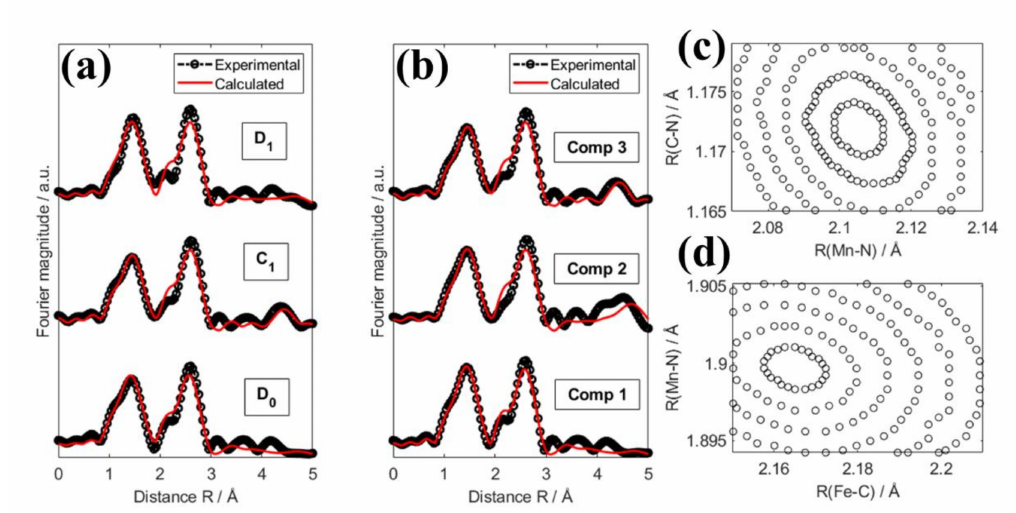
Figure 6. EXAFS fitting analysis on ( a ) the most relevant states of charge, i.e., D 0 , C 1 , and D 1 , as well as ( b ) all three components retrieved by the MCR-ALS analysis. The experimental Fourier transform signal is compared to the calculated one in all instances. ( c , d ) Examples of contour plots for the error parameter determination. These refer to highly correlated parameters; the inner elliptical circle corresponds to a 95% confidence level.